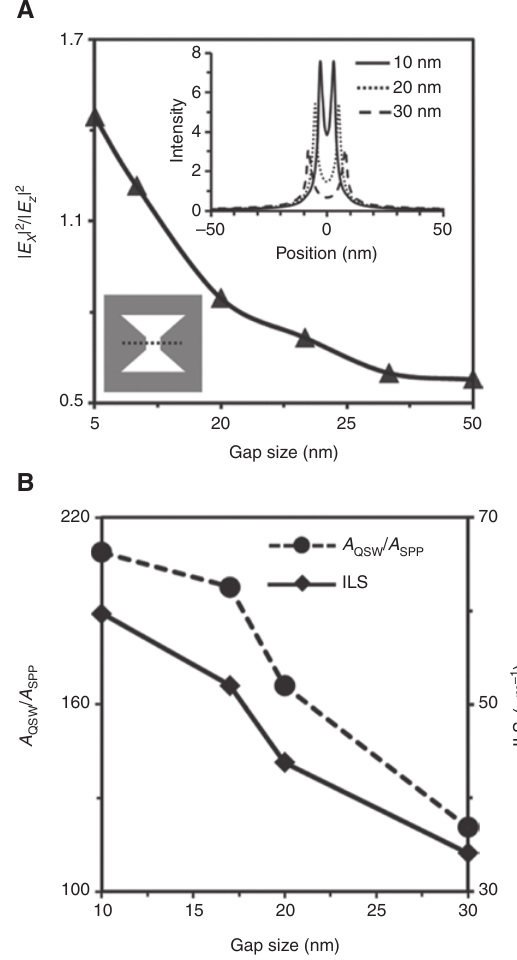
Figure 6: Effects of the gap size on the quality of the aerial image. (A) Calculated ratio | E | 2 / | E | 2 as a function of the gap size. The x z inset shows the transmitted intensity profile through the different gap sizes at the gap center along the x -direction. (B) Calculated ratio A / A from the photoresist point-spread functions (PSFs) QSW SPP generated by the plasmonic BNA with gap sizes of 10, 17, 20, and 30 nm and calculated ILS as a function of the gap size at the edge position of the line patterns with a 100-nm top CD.